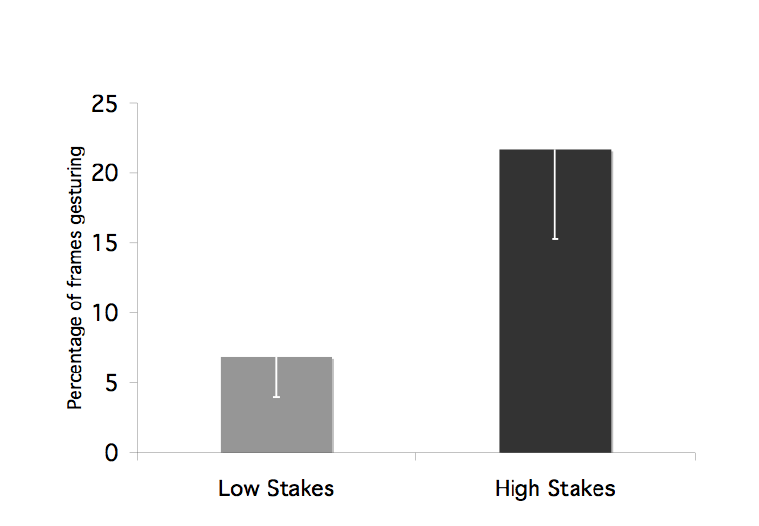
Figure 1. Mean percentage of total frames spent gesturing as a function of stakes of communication ( n = 20). Error bars reflect standard error of the